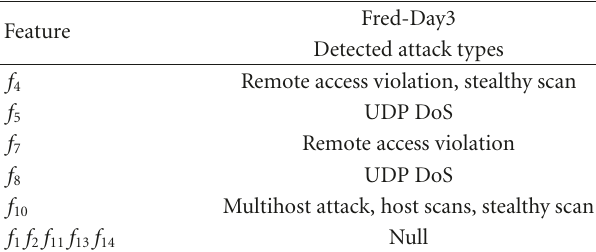
Table 11: Number of attack types detected for each feature for Fred- Day3.